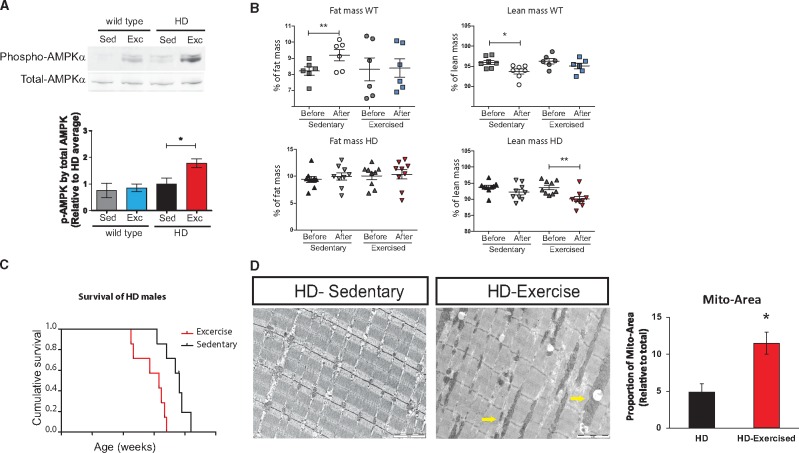
Endurance exercise is detrimental for HD. (A) Immunoblots for AMPKα activation in TA muscles (n = 4 in WT, n = 6 in HD groups) after 6 weeks of sedentary or exercise (B) Whole body fat and lean mass in male WT (n = 5) and HD (n = 7) mice before (around 7–8 weeks of age) and after 6 weeks sedentary or exercise regime. (C) Graph showing decrease survival in HD mice with endurance exercise (n = 7; P = 0.003). (D) TEM images from TA muscles of HD mice in the sedentary and exercise group (yellow arrow pointed at mitochondria). Quantification of the average mitochondria total area in TEM. Each bar represents the average of n = 2–4 mice per group in at least three comparable micrographs per mouse including 40–60 mitochondria per micrograph. Graph bars represent mean ± SEM. Statistical evaluation between HD groups by two-tailed t-Student with Welch’s correction. *P < 0.05, **P < 0.01.